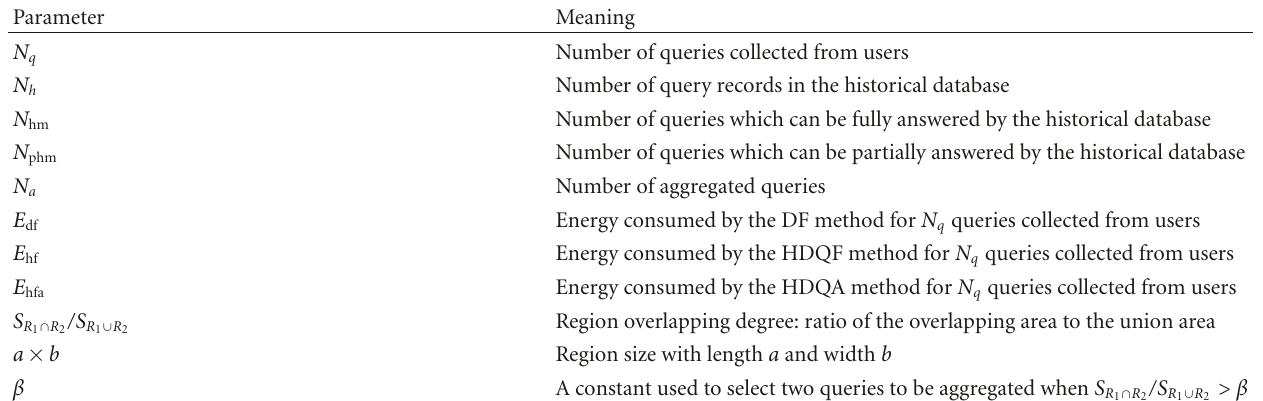
Table 2: Simulation parameter